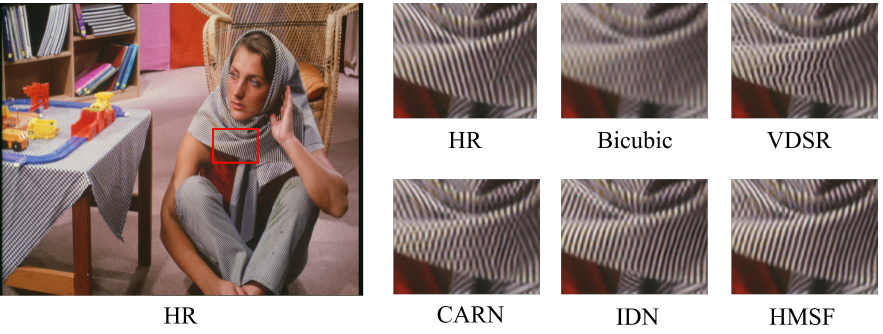
Figure 17. Failure case. A failure example of 2 × SR; our HMSF cannot correctly restore the direction of the stripe of the textile, with its complex detail and misleading